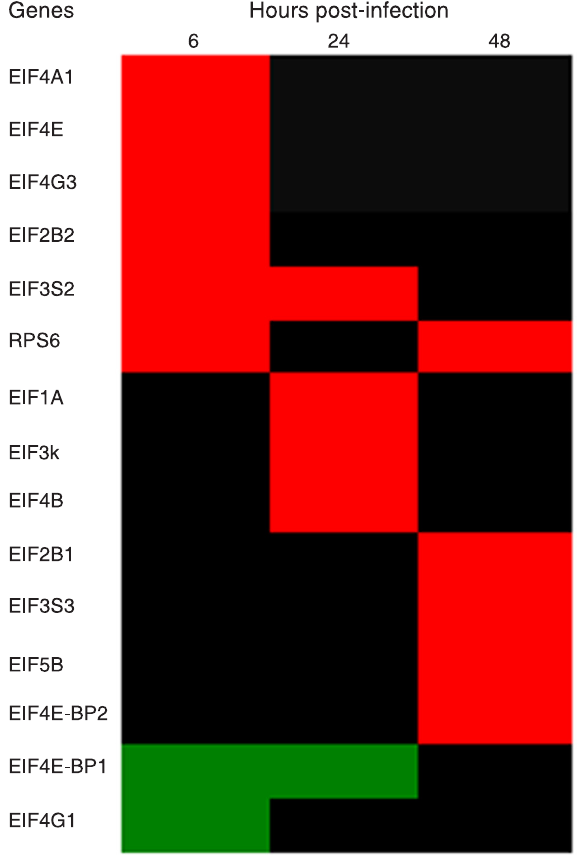
Figure 1. Modification of the expression of genes related to translation and to the target of rapamycin pathway after infec- tion with dengue virus. Alterations in the transcription of genes related to translation are represented. Genes are colored if their corresponding mRNA is up-regulated with a Z-score ≥ 2.0 (red), down-regulated with Z-score ≥ -2.0 (green) or with no change (black) at each time of